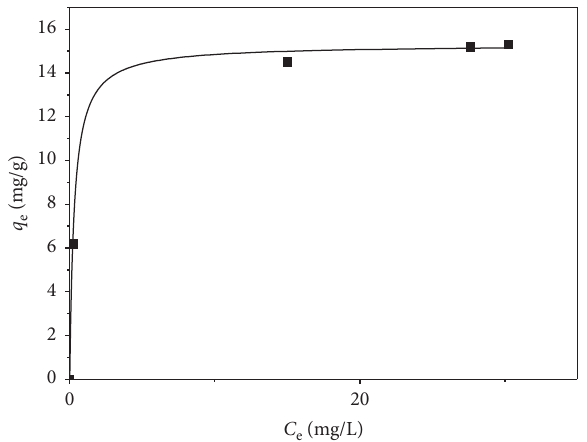
Figure 10: Adsorption isotherm of MO onto sugar scum powder (adsorbent dose � 16g/L; pH � 7.21; T � 22 ° C).